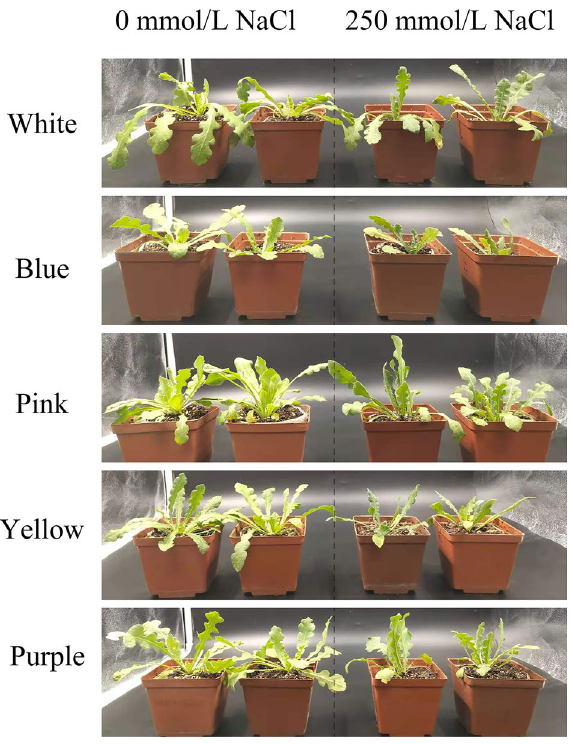
Figure 3. Growth of five varieties of Limonium sinuatum seedlings after two weeks of salt